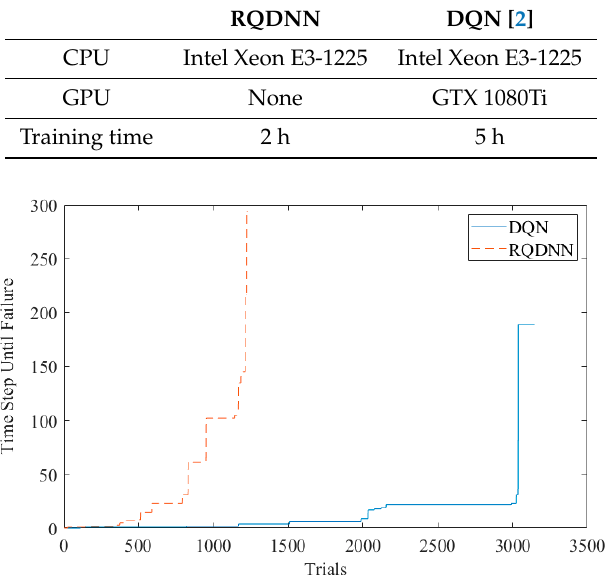
Table 4. Hardware configurations of RQDNN and DQN [2]